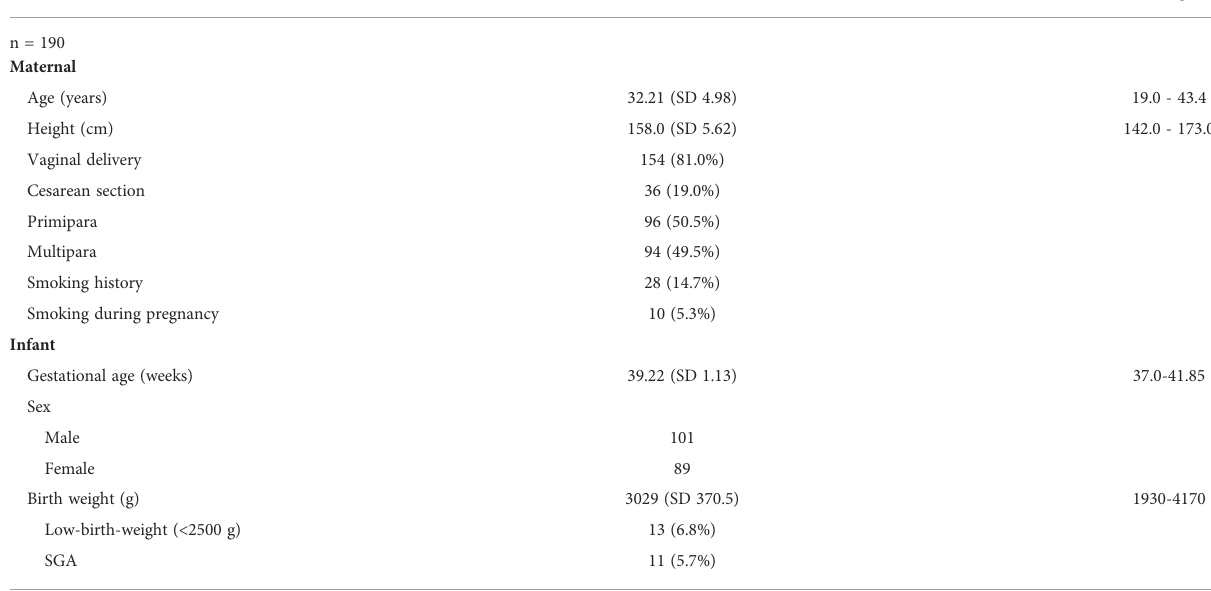
TABLE 1 Maternal and neonatal background